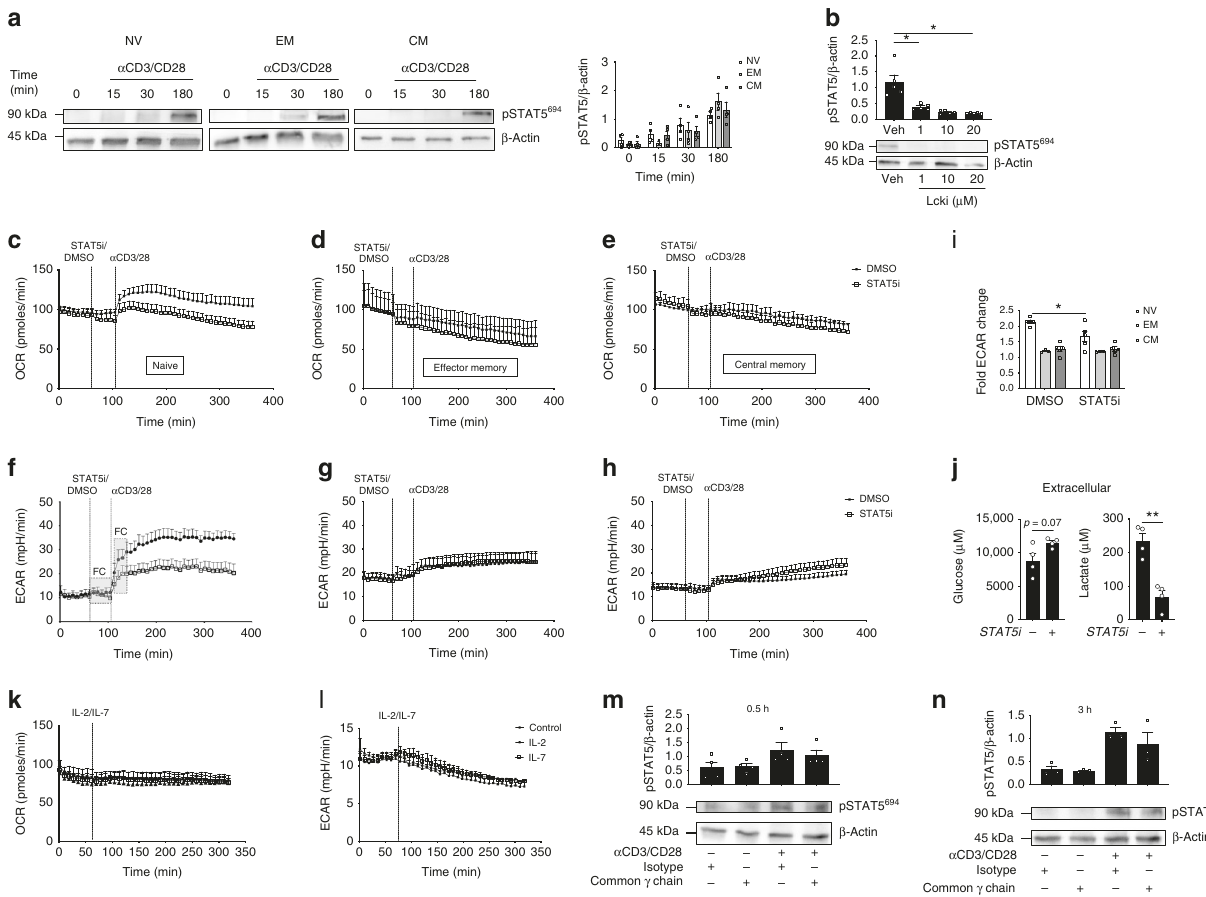
Fig. 5 STAT5 orchestrates the metabolic switch in activated NV T-cells. a Immunoblot for pSTAT5 Tyr694 and β -actin in NV, EM and CM T-cells following 0, 15, 30 and 180 min of activation with anti-CD3/CD28. Densitometry of pSTAT5 Tyr694. b Immunoblot for pSTAT5 Tyr694 and β -actin in NV T-cells activated with anti-CD3/CD28 in the presence (1, 10 and 20 μ M) or absence (Veh) of a lck inhibitor. OCR ( c – e ) and ECAR ( f – h ) was measured in NV ( c , f ), EM ( d , g ) and CM ( e , h ) CD4 + T-cells in the absence (DMSO) or presence of a STAT5 inhibitor (100 μ M) before cells were activated with anti-CD3/ CD28 at the indicated time points. i Fold change in ECAR upon activation calculated using the measures in the FC box. j Extracellular glucose and lactate production in activated NV T-cells (anti-CD3/CD28) in the absence or presence of STAT5i (100 μ M) for 4 h. OCR ( k ) and ECAR ( l ) of NV T-cells activated with either IL-2 or IL-7 (10 ng/mL). Immunoblot of pSTAT5 Tyr694 and β -actin in NV T-cells activated with anti-CD3 (2 μ g/mL) and anti-CD28 (20 μ g/mL) with common γ chain antibody or isotype control (1 μ g/mL) for m 0.5 or n 3 h. Statistical analysis was performed using a non-matching two- way ANOVA with Sidak ’ s multiple comparison test ( a , i ), a paired t- test ( j ) or a matched Friedman test with Dunn ’ s multiple comparisons test ( m , n ). Data are representative of a 3 – 5 experiments with one representative immunoblot sample of 3 – 5 is shown, fi ve ( b , c , e , f , h ), three ( d , g , n ), four ( j , m ) or two independent experiments ( k , l ) and expressed as mean ± SEM; * p ≤ 0.05, ** p ≤